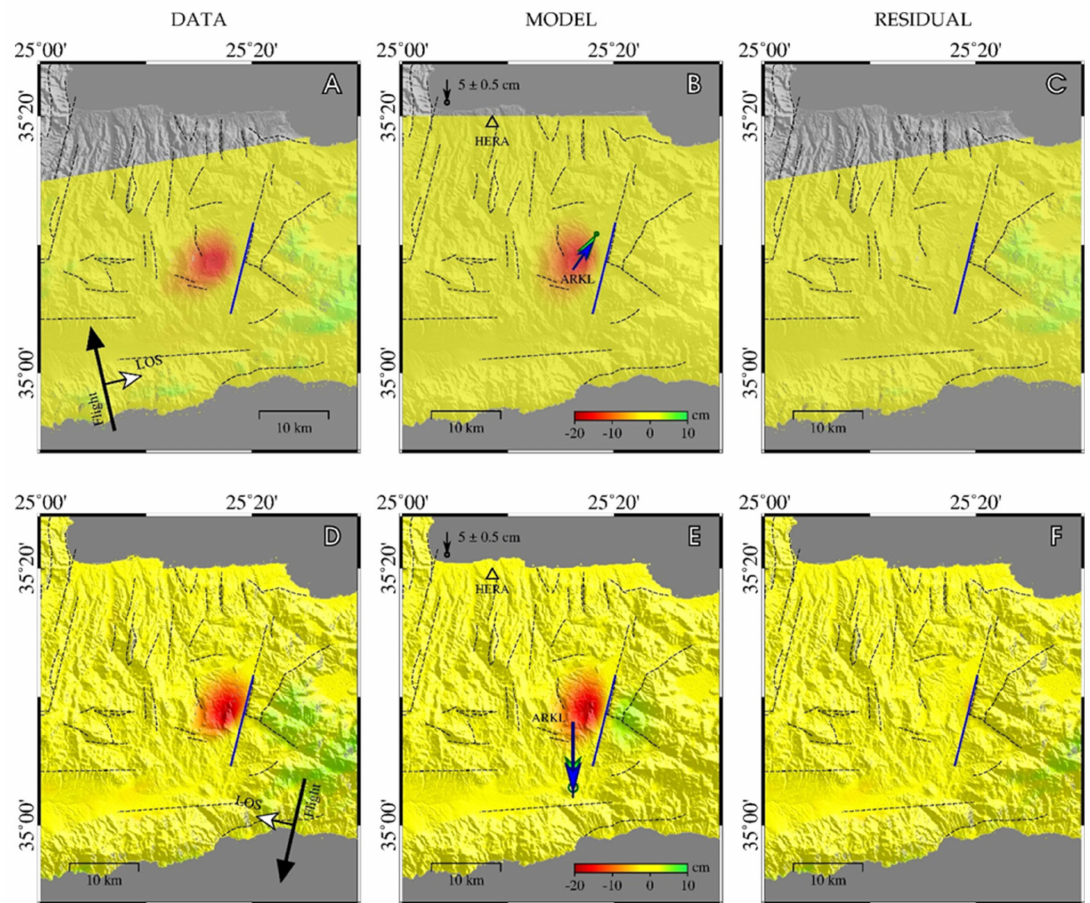
Figure 7. InSAR unwrapped data ( A ), model ( B ) and residual (Data-Model; C ) for ascending and descending ( D – F ) orbits. GPS solution (green arrows) and model (blue arrows) for ARKL station are also presented. Panel B shows the horizontal displacement and panel E shows the amount of subsidence of ARKL GNSS station. Thin dotted lines are active faults [47]. Thick blue line indicates the intersection of the seismic fault with the Earth’s